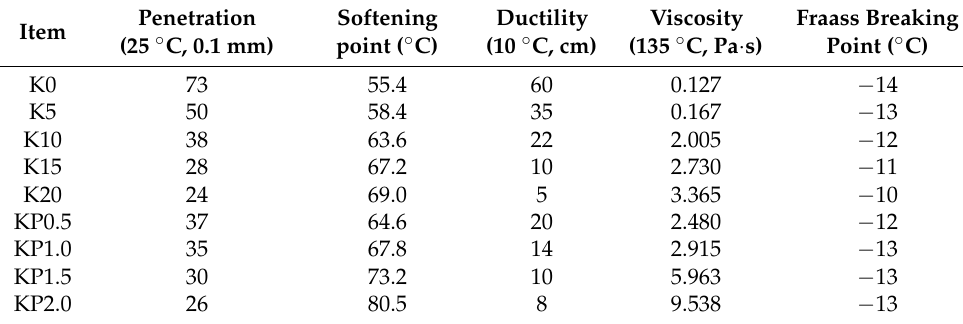
Table 6. Conventional properties of modified